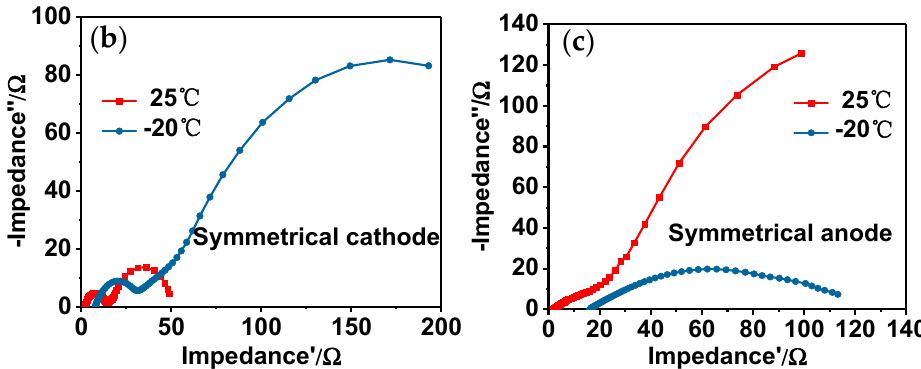
Figure 5. Electrochemical impedance spectroscopy (EIS) and equivalent circuit for symmetrical device: ( a ) schematic diagram and equivalent circuit for the symmetrical device; ( b ) complex-plane plot of impedance at 25 °C and − 20 °C for the symmetrical device based on cathode; ( c ) complex-plane plot of impedance at 25 °C and − 20 °C for the symmetrical device based on anode.